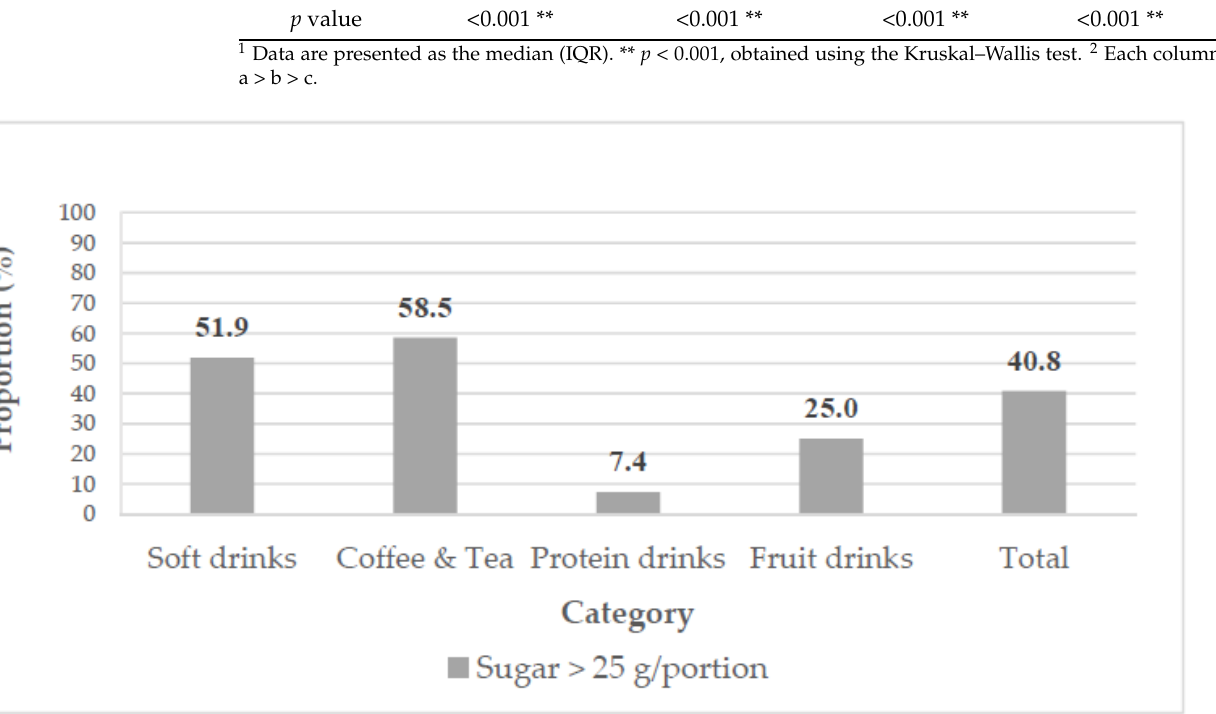
Table 5. Description of energy and sugar content among different SSBs 1,2 .